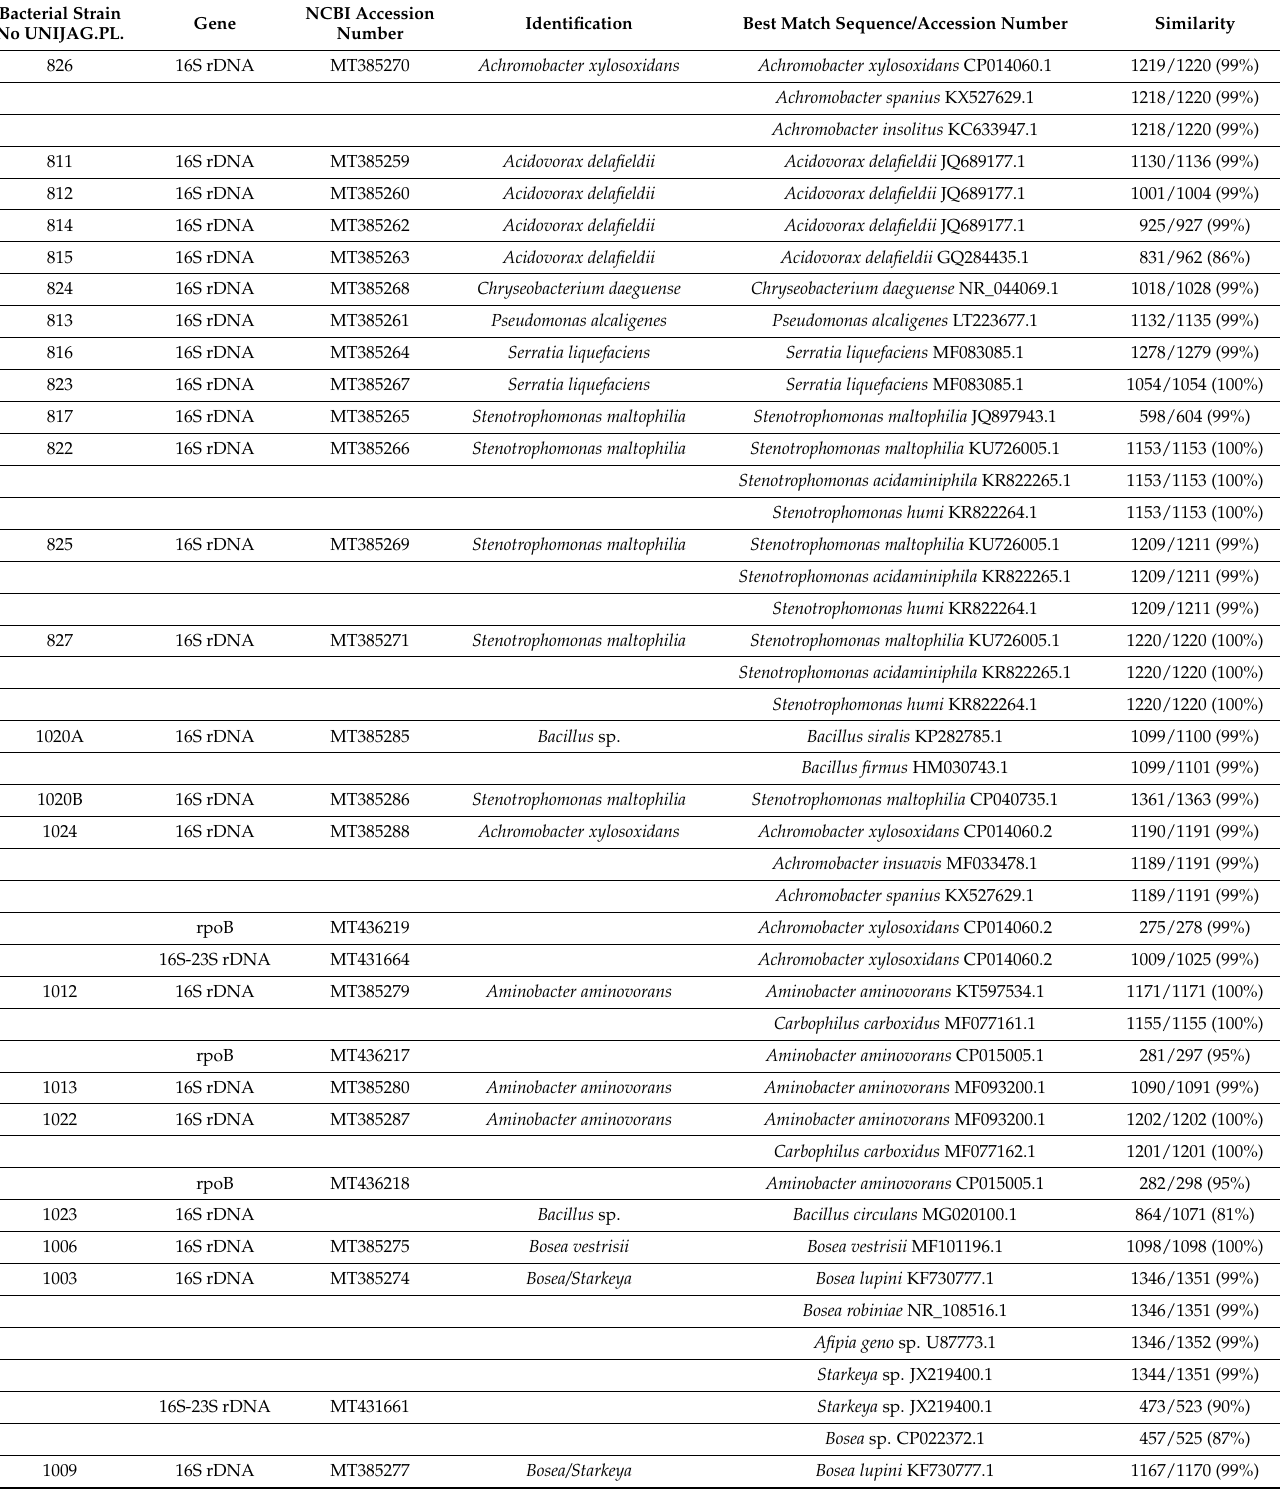
Table 1. Molecular identification of bacteria isolated from Zoophagus insidians . Bacterial Strain No